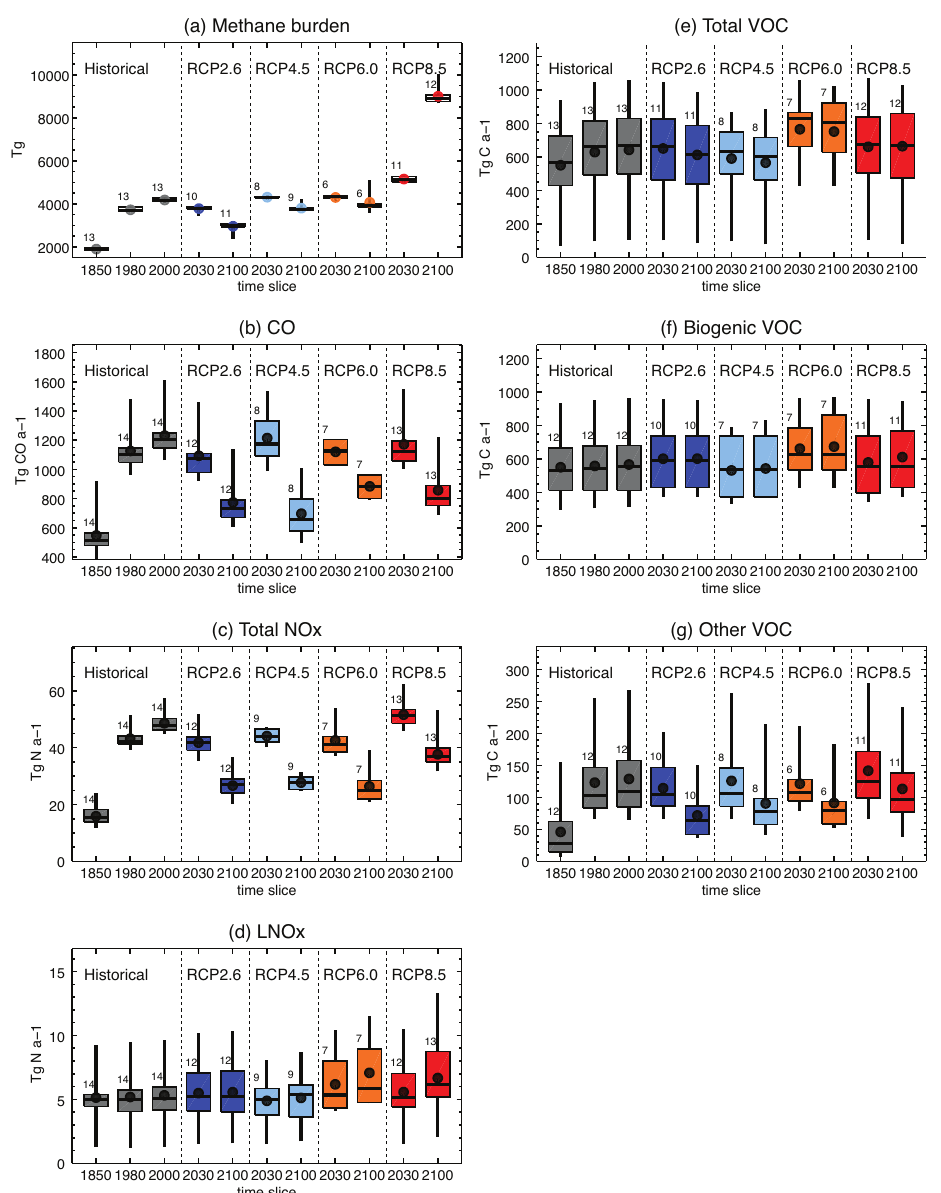
Fig. 1. Burdens and emissions of ozone precursors used in the ACCMIP scenarios and time slices, showing (a) the tropospheric methane burden, and yearly total (b) CO emissions, (c) total NO x emissions, (d) lightning NO x emissions and (e) total VOC emissions, which are then split into (f) biogenic VOCs and (g) other VOCs. The spread of the emissions/burden in each model is indicated for each scenario and time slice, with filled box showing the interquartile range, the whiskers indicating the full range, and the dot and line indicating the mean and median respectively. Not all models completed all the scenarios: the number of models used to determine each box/whisker is